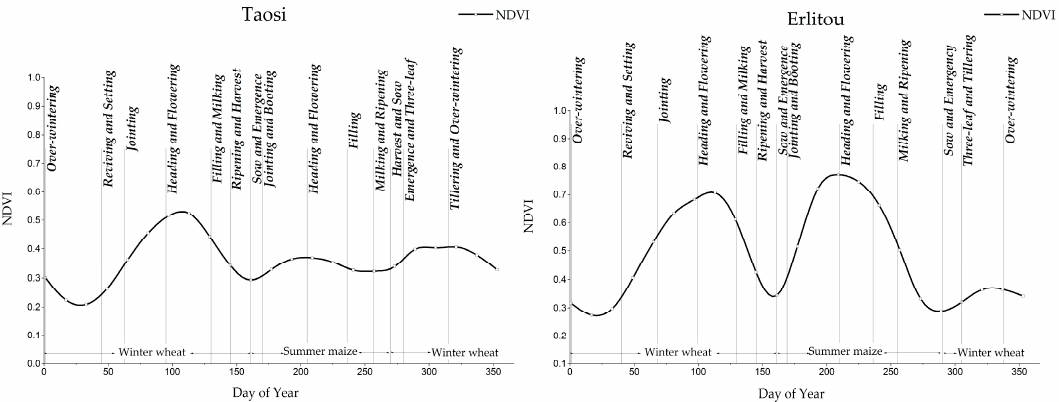
Figure 2. The NDVI average curves of each sample with planting time and growth stages indicated.